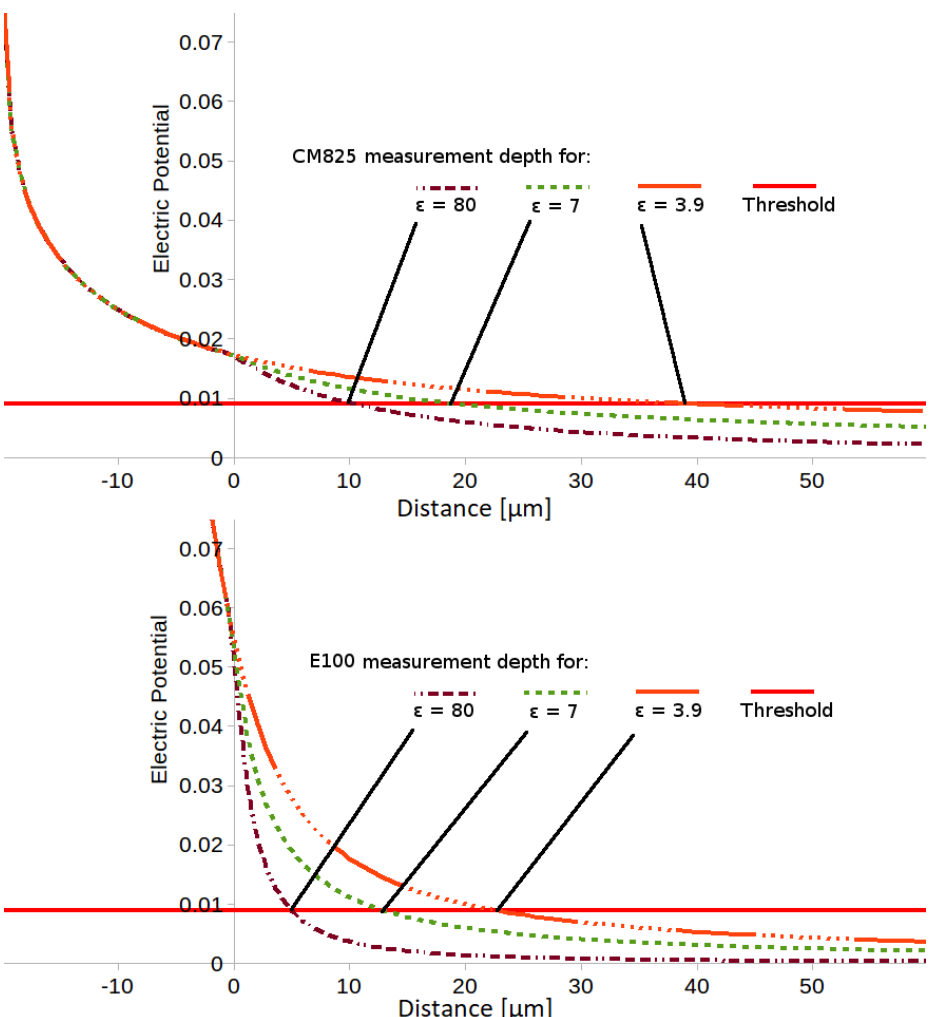
Figure 3. Maxwell-based simulation results to compare measurement depth between Corneometer CM825 and Epsilon E100. The end of the protective layers is overlapping with the y-axis (x = 0). Therefore, electric potential readouts at the left of the y-axis (x < 0) are inside the protective layer, while readouts at the right of the y-axis (x > 0) are taken from within the sample under examination. Also, the electric potential on the electrode surface is configured to 0.3 V, but the upper part is cropped for better visualization of the results. The horizontal line at 0.09 V represents the 3% depth